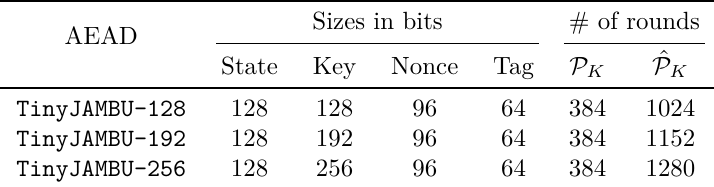
Table 1: The three variants of TinyJAMBU